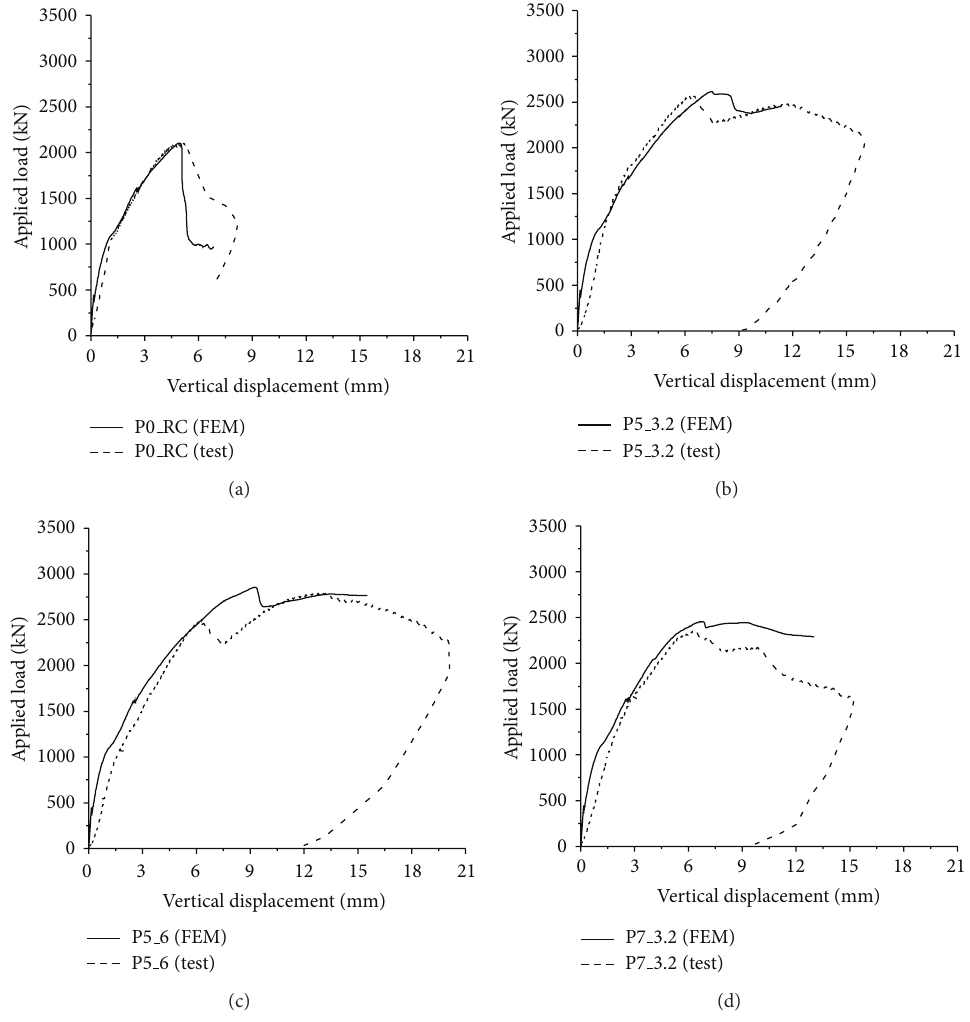
Figure 13: Comparison with test results: (a) P0 RC; (b) P5 3.2; (c) P5 6; and (d) P7